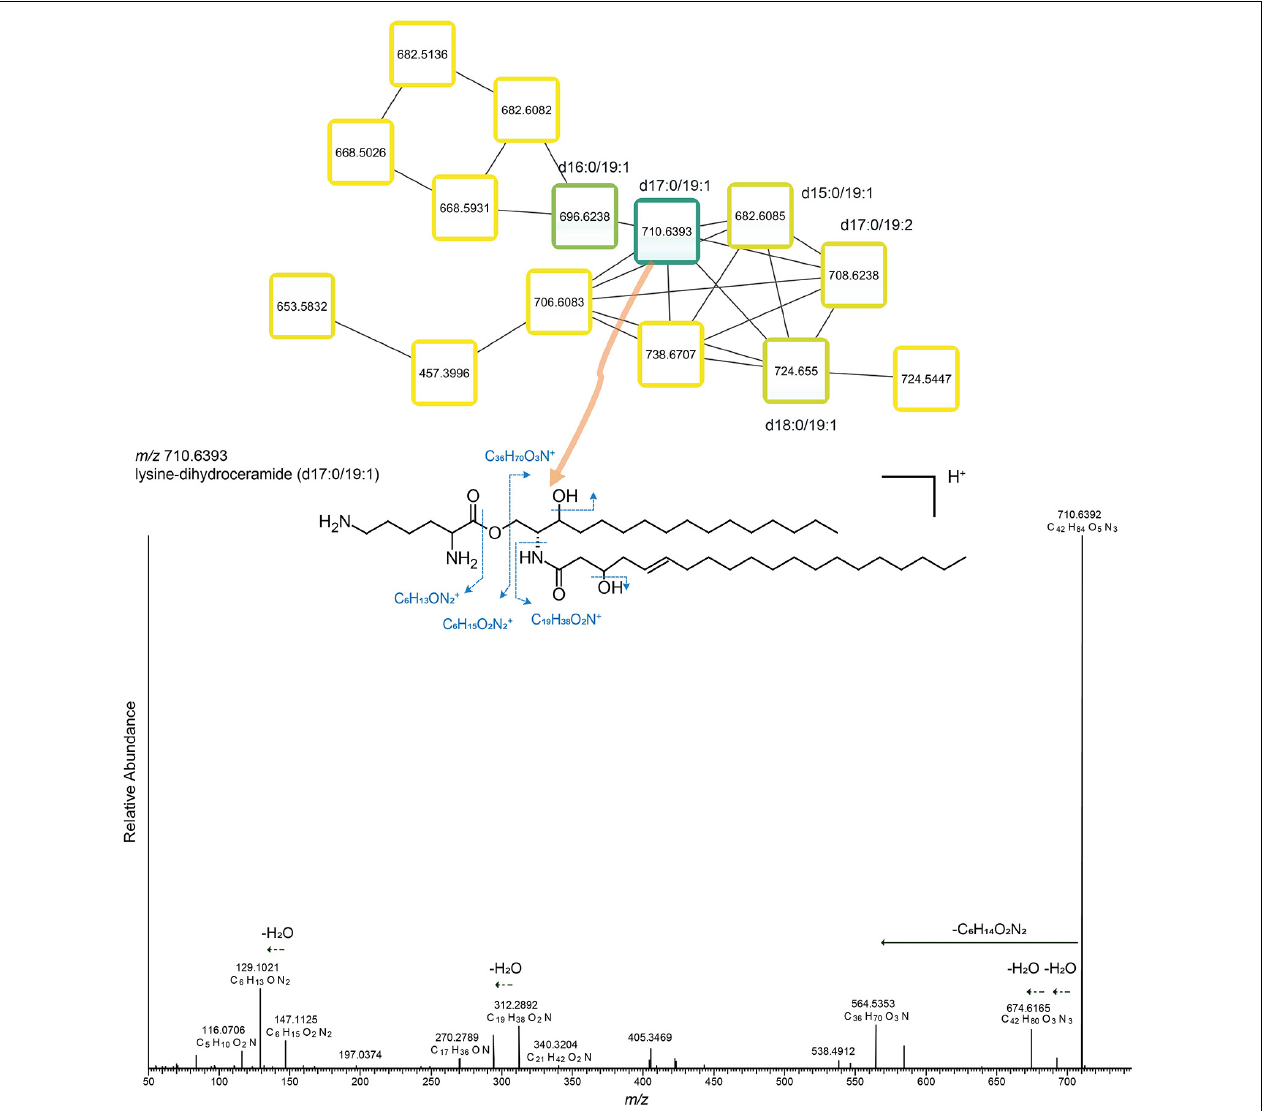
FIGURE 7 | Molecular subnetwork of sphingolipids3. Boxes shown in subnetwork are the same as nodes shown in Figure 2 , representing lipid species. The outlines of the boxes are labeled from light yellow to dark blue with the increasing of the summed intensity among all the water column samples (15 depths). Inside the box, a heatmap represents the distribution of this lipid species across the water column, from top (50 mbsl) to bottom (2,000